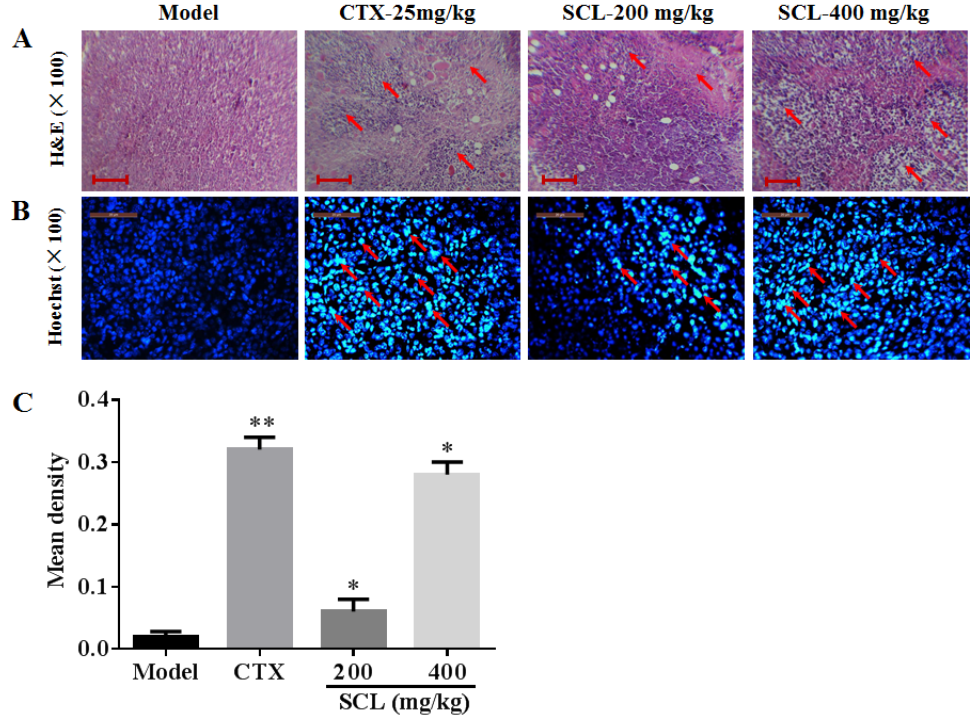
Figure 4. Histological examination of the morphological changes in tumors from H22-bearing mice. Tumor tissues stained with H&E (100×) ( A ) and Hoechst 33258 (100×) ( B , C ). The images were analyzed by an Image-Pro plus system. All data were expressed as the mean ± standard deviation (SD). * p < 0.05, ** p < 0.01 vs. the model group. The changes of the tumor cells are marked by arrow heads. Bar: 25 μ m. n = 10.